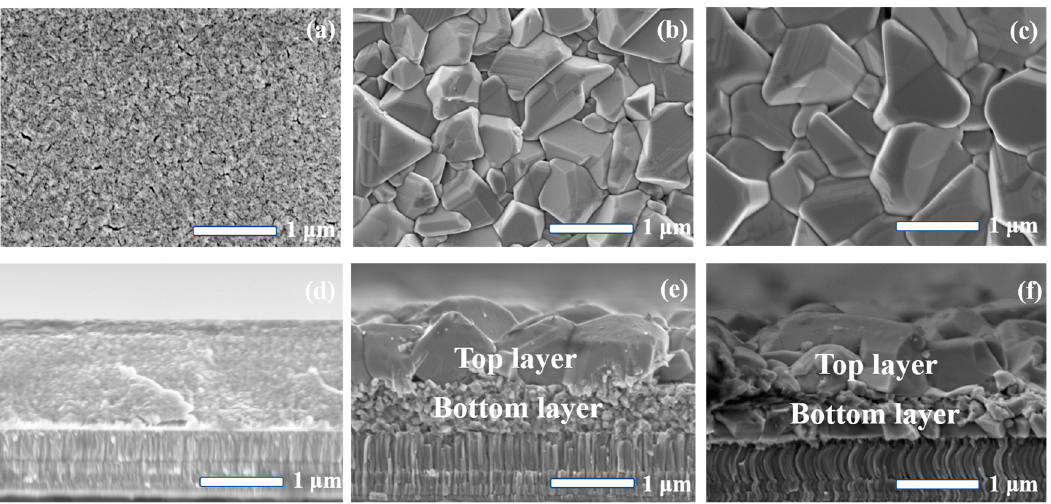
Figure 1. Surface and cross-sectional SEM images of ( a , d ) CZTS precursor film, ( b , e ) CZTSSe film with